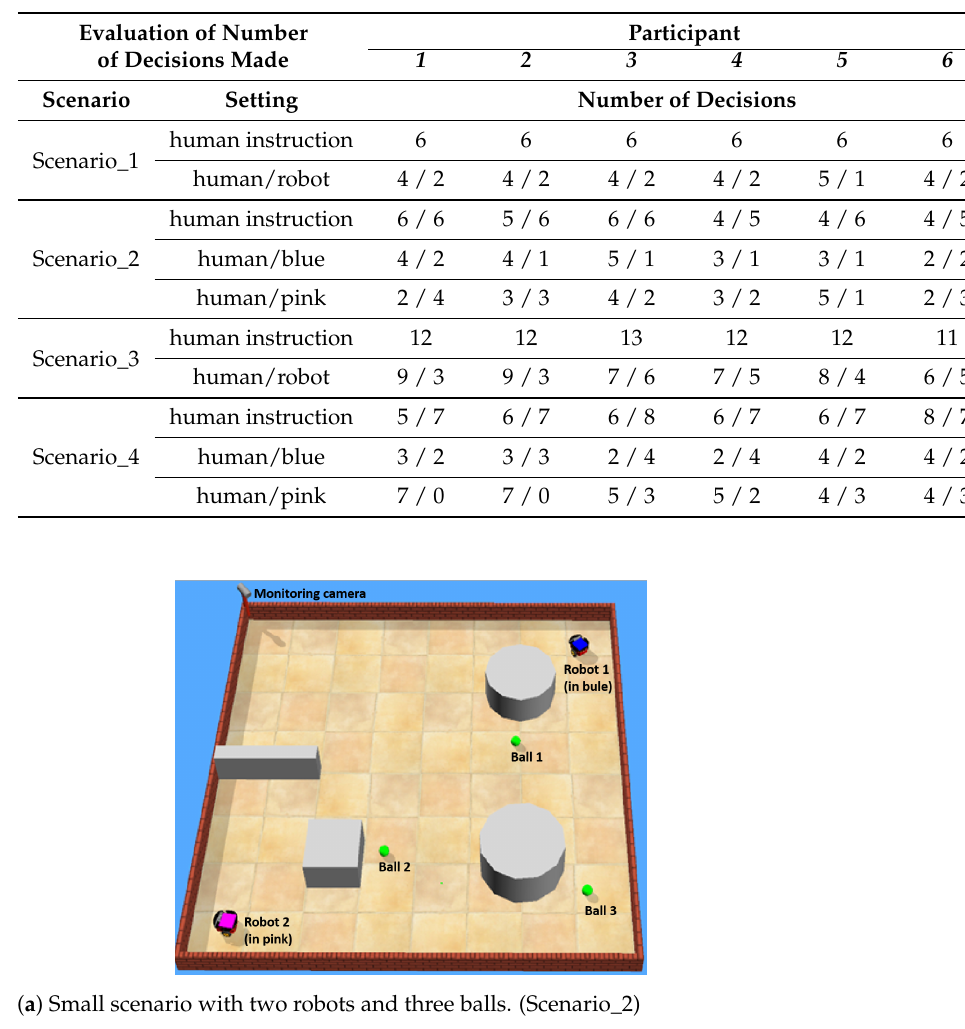
Table 3. Number of decisions made in Scenarios_1–4.